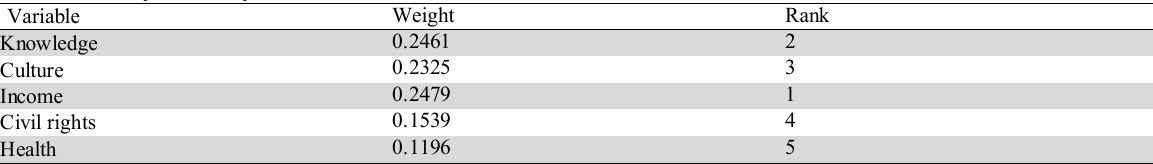
The summary of fuzzy AHP